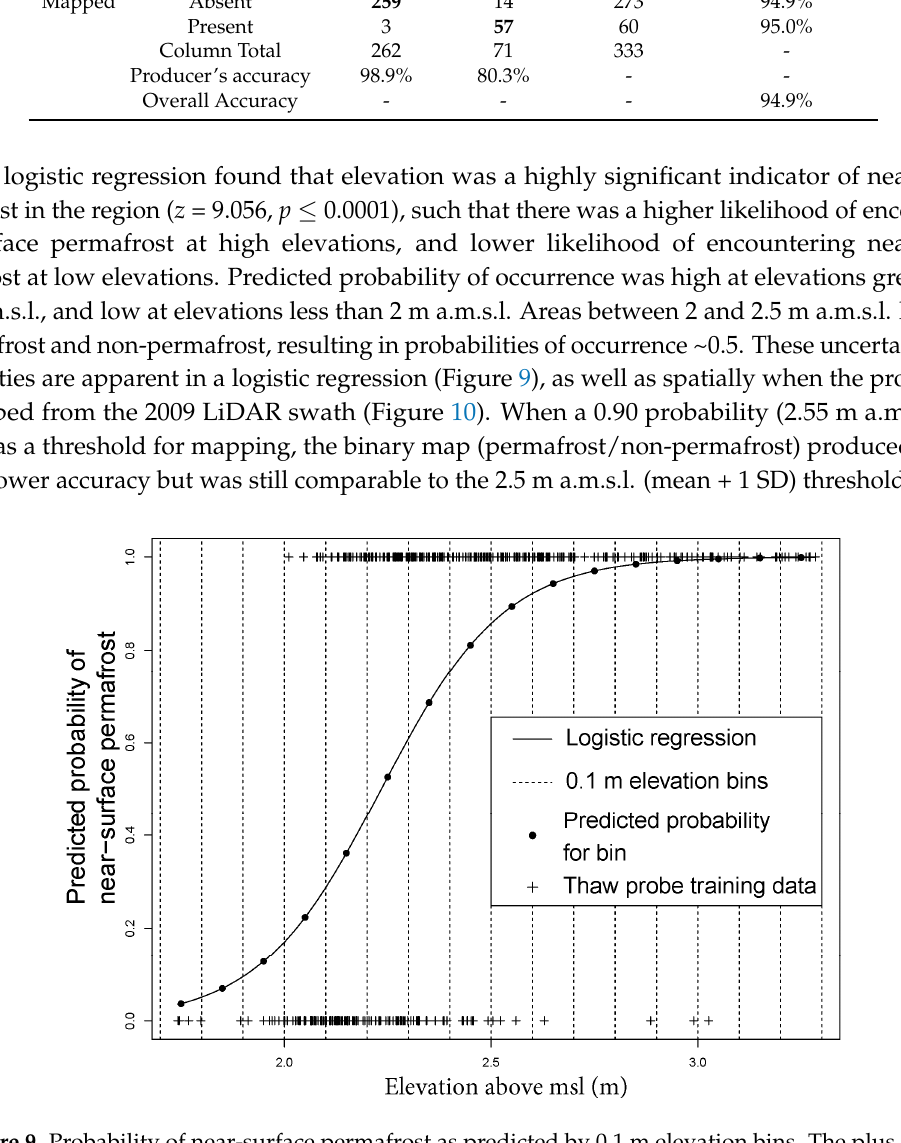
Figure 9. Probability of near-surface permafrost as predicted by 0.1 m elevation bins. The plus signs show permafrost observations (1 = permafrost, 0 = non-permafrost) plotted by elevation; permafrost only occurs at the top of the plot (probability = 1), and absence of permafrost only occurs at the bottom (probability = 0) because of the binomial nature of